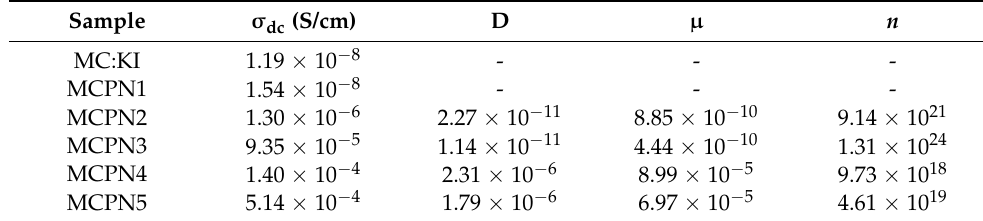
Table 1. Ion transport parameters of different plasticized systems.